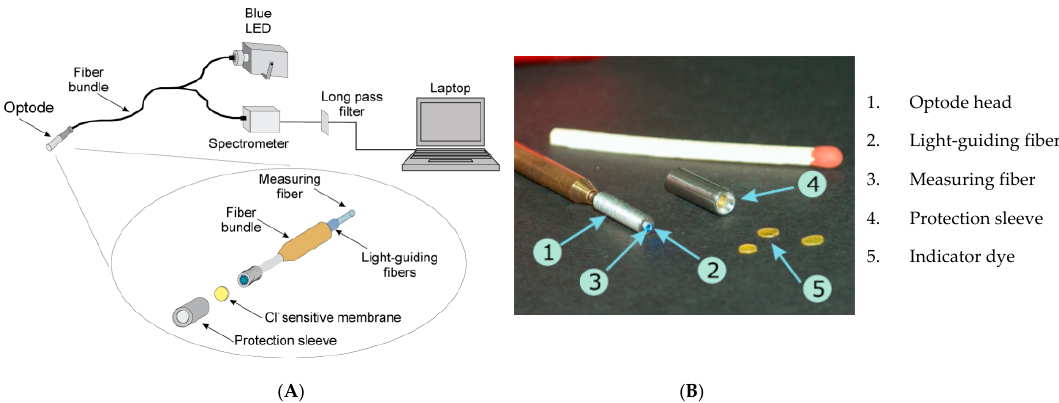
Figure 5. ( A ) Schematic representation of optical fiber based Cl − sensor measurement setup, ( B ) components of the sensor [60].